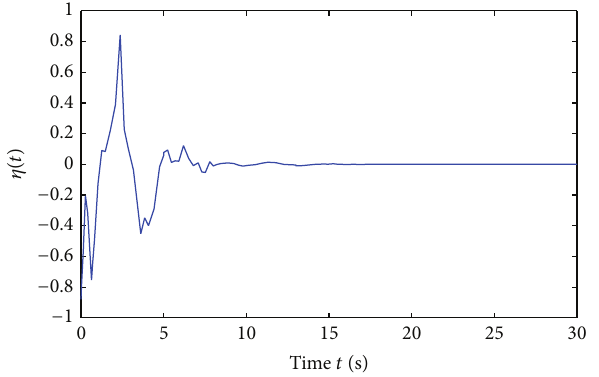
Figure 3: Estimated signals error 𝜂(𝑡) = 𝑧(𝑡) − ̃𝑧(𝑡)